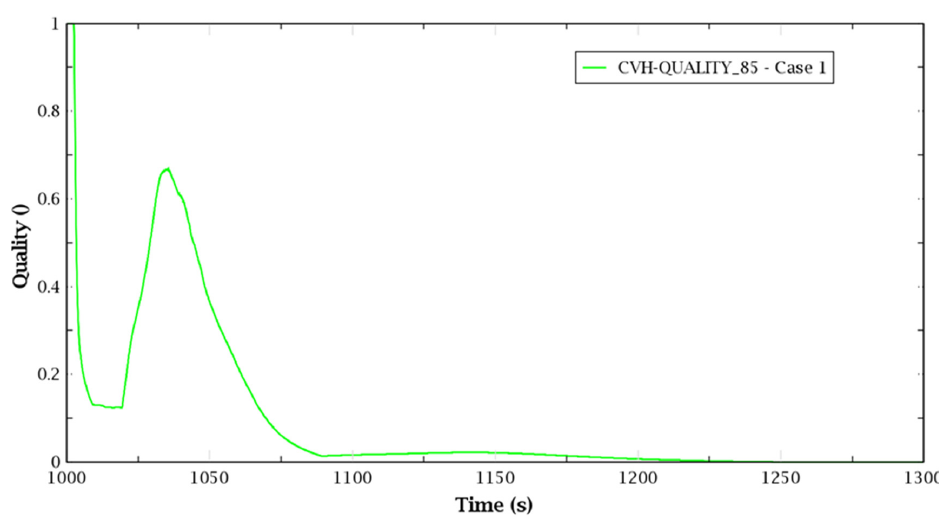
Figure 7. Vapor quality in volume 85 for Case 1.